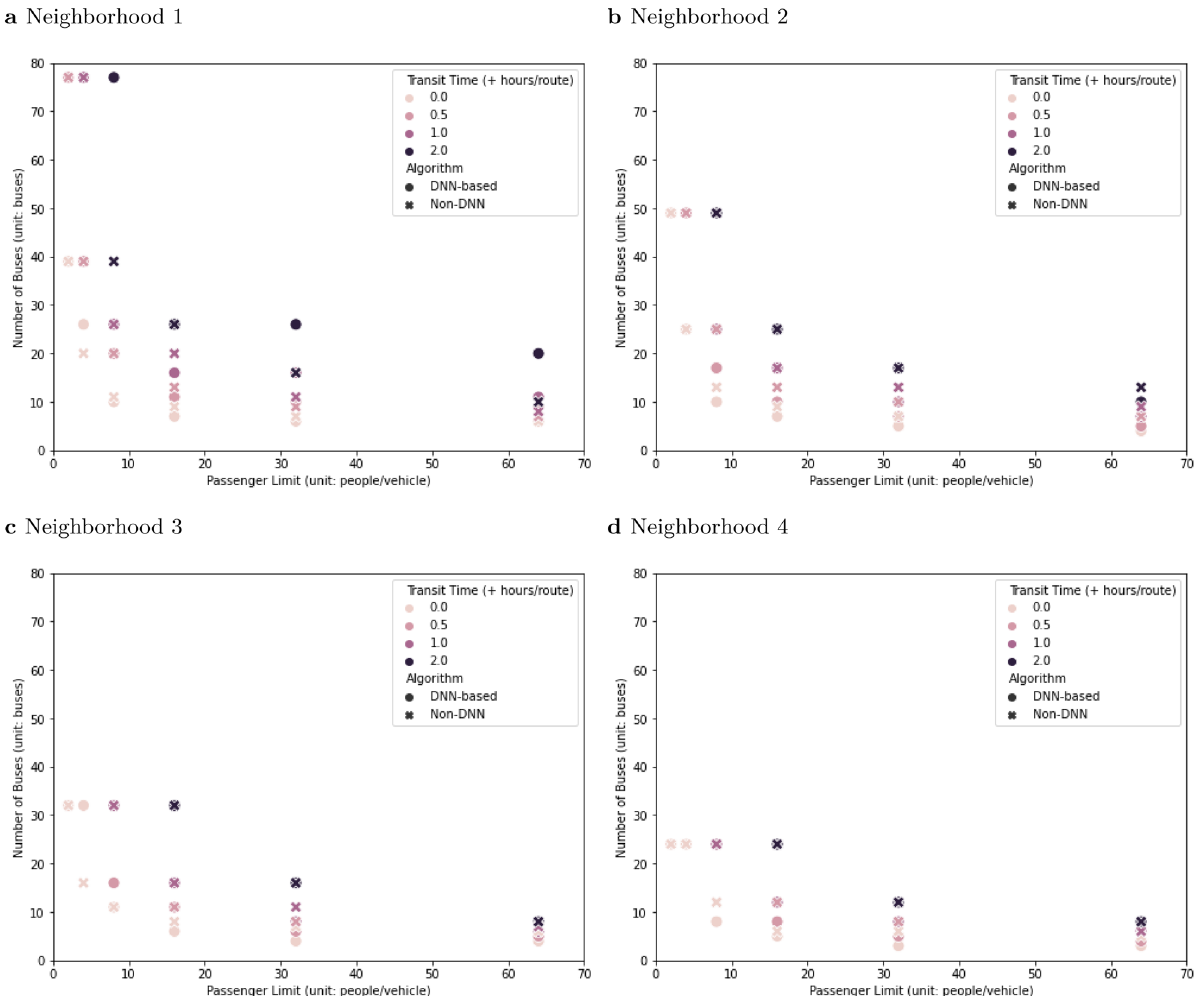
Figure 6. Social distancing and the number of vehicles required to evacuate a city. The x-axis is vehicle capacity, and the y-axis indicates the number of vehicles required to evacuate 4000 people. If it is impossible to evacuate one neighborhood within 42 h, data points are not shown. ( a ) Neighborhood 1 has 52 people and 20 houses on the special needs registry. ( b ) Neighborhood 2 has 83 people and 35 houses. ( c ) Neighborhood 3 has 126 people and 52 houses. ( d ) Neighborhood 4 has 168 people and 68